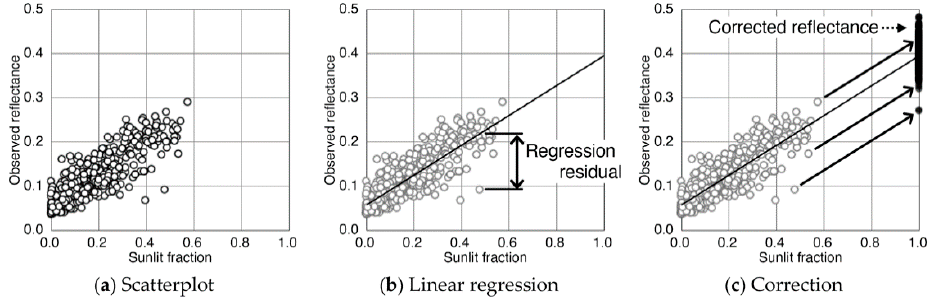
Figure 3. Outline of the scene-based correction. ( a ) Scatterplot of the sunlit fraction and reflectance of Sentinel-2/MSI observed on 12/25/2018; ( b ) linear regression and regression residuals; and ( c ) correction of reflectance at 1.0 sunlit fraction.